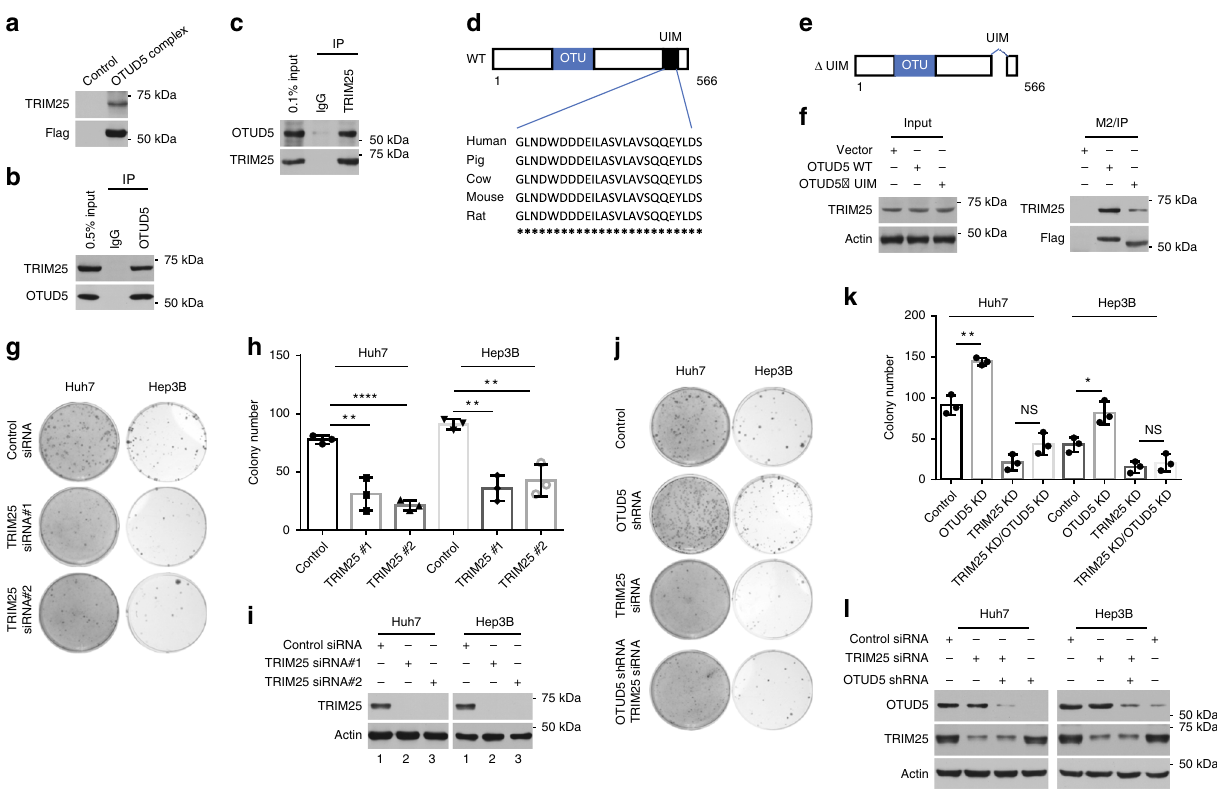
Fig. 2 OTUD5 knockdown promoted cell growth in a TRIM25-dependent manner. a TRIM25 was easily detected in the OTUD5 complex. b and c OTUD5 endogenously interacts with TRIM25. IP: immunoprecipitation. d Cross-species alignment of the UIM of OTUD5. WT, wild type. e Schematic representation of the UIM-deleted OTUD5 construct used in f . f UIM deletion inhibited the interaction between OTUD5 and TRIM25. g Huh7 and Hep3B cells were transfected with control siRNA or siRNA against TRIM25 (TRIM25 siRNA#1 and TRIM25 siRNA#2). The colonies were visualized by staining with methylene blue after the cells were cultured for 10 days. h Quantitation of colonies in g . Data represent the means ± SD from three repeated 35 mm dishes. ** p = 0.005 (siControl versus siTRIM25 #1 in the Huh7 cells), **** p < 0.0001 (siControl versus siTRIM25 #2 in the Huh7 cells), ** p = 0.0013 (siControl versus siTRIM25 #1 in the Hep3B cells), ** p = 0.0046 (siControl versus siTRIM25 #2 in the Hep3B cells), two-tailed unpaired t -test. i TRIM25 knockdown ef fi ciency by one of the two different siRNAs in both the Huh7 and Hep3B cells as determined by western blot analysis. j Representative images of the colonies showing that the growth acceleration of OTUD5 depletion was compromised by TRIM25 knockdown. k Quantitation of the data shown in ( j ). Data represent the means ± SD from three repeated 35 mm dishes. ** p = 0.0019 (shControl versus shOTUD5 in the Huh7 cells), * p = 0.016 (shControl versus shOTUD5 in the Hep3B cells), two-tailed unpaired t -test. NS, non-signi fi cance. l The knockdown ef fi ciency of OTUD5 and TRIM25 was assayed by western blot using an anti-OTUD5 antibody and anti-TRIM25 antibody. β -actin served as a loading control. Source data are provided as a Source Data fi